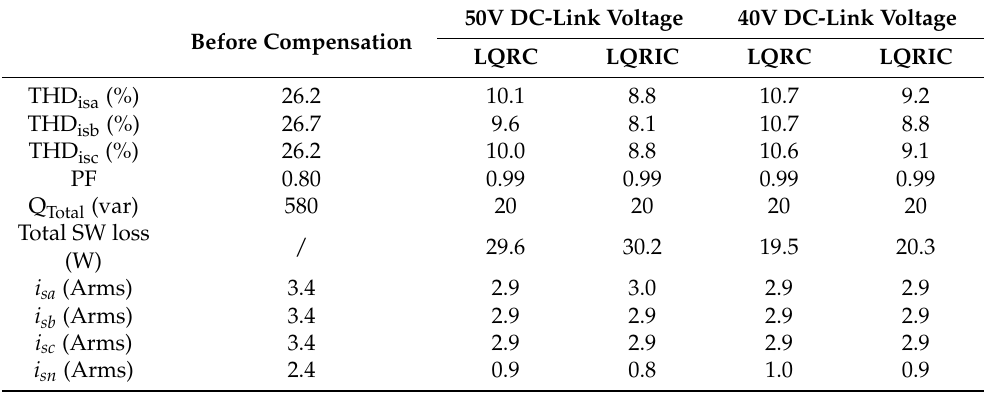
Table 4. Experimental results before and after the LC -HAPF compensation with LQRC and LQRIC. Before